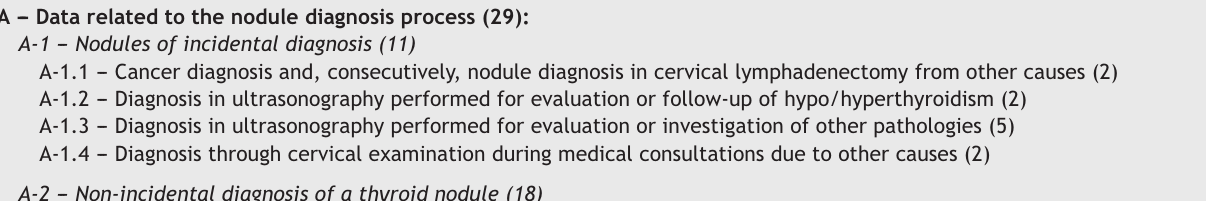
Content analysis: categorization and codification of the diagnostic process of nodules and of thyroid cancer cases among thyroid